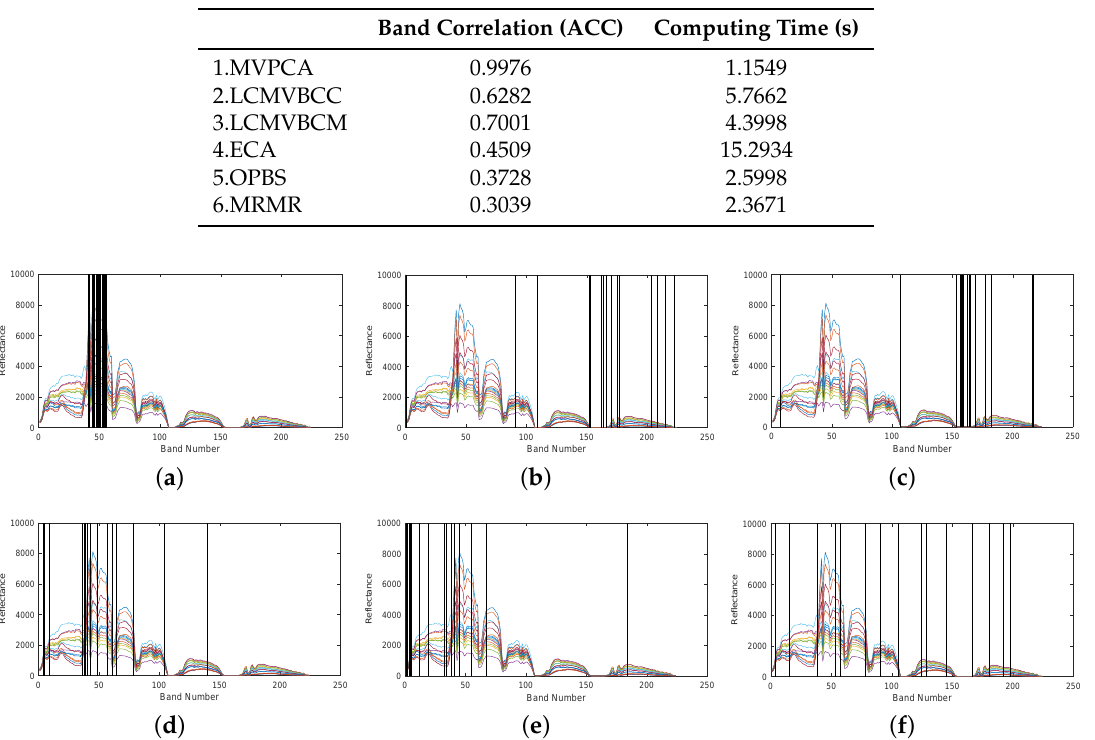
Average band correlation and computing time for selecting fifteen bands from the Salinas dataset.